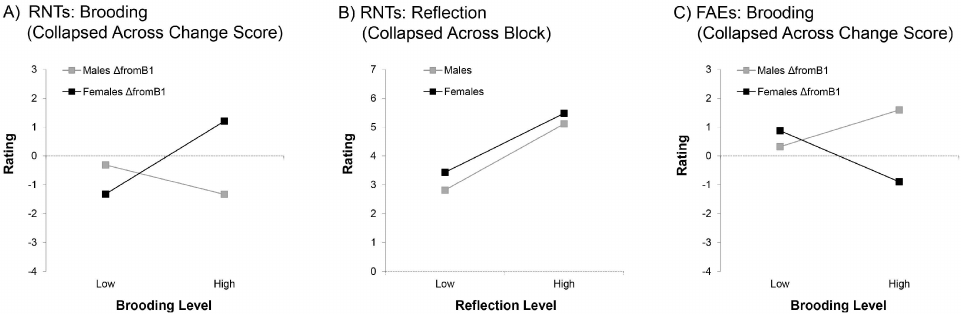
Figure 3. First-test subjective experiences as a function of RRS and gender. ( A ) Effects of Brooding on change in RNTs between Block 1 and subsequent blocks; ( B ) Effects of Reflection on RNTs collapsed over four blocks; ( C ) Effects of Brooding on change in FAEs between Block 1 and subsequent